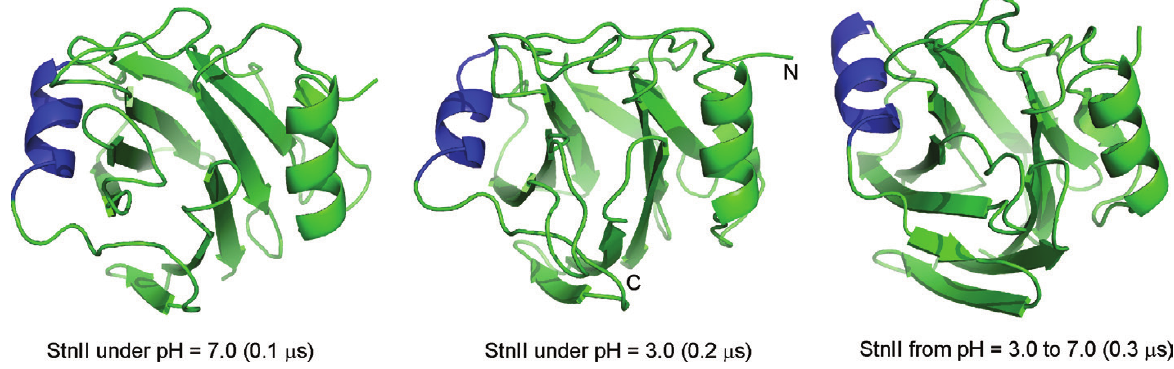
Figure 7 - Conformational transitions of StnII over 0.3 μs MD simulation as a function of solution pH. The helical content was analyzed employing the progression of the average pseudo dihedral ξ, that is, the dihedral formed by 4 consecutive α-carbon atoms Cαi, Cαi , Cαi and Cαi (see text and supplementary material for +1 +2 +3